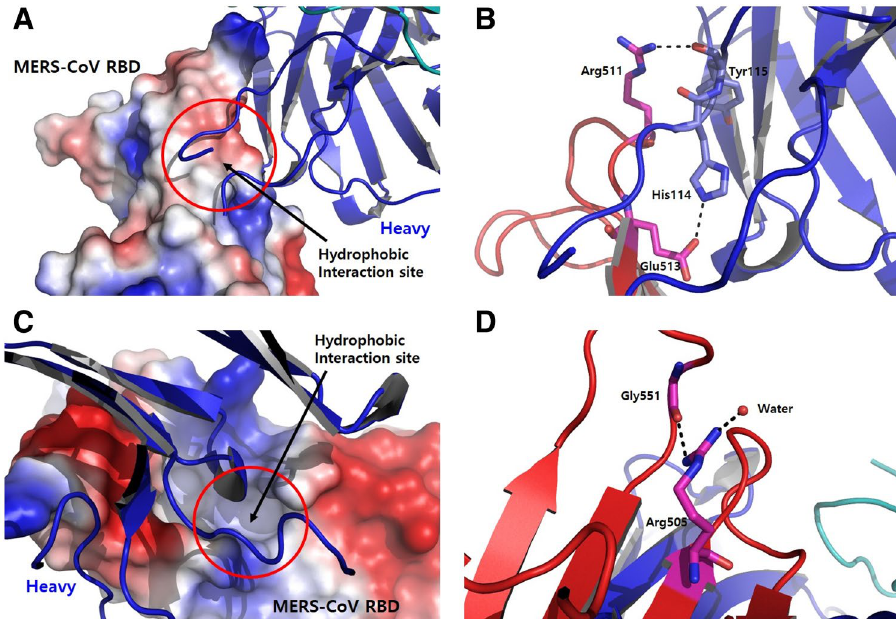
Figure 4. The hydrophobic interaction sites of MERS-CoV RBD complexed with KNIH90-F1 Fab. ( A ) The hydrophobic residues in the heavy chain of KNIH90-F1 Fab make contact with the hydrophobic region in the receptor-binding subdomain of RBD. ( B ) The hydrophobic interaction in ( A ) is reinforced by the interactions between Arg511 in RBD and Tyr115 in the heavy chain and between Glu513 in RBD and His114 in the heavy chain. ( C ) An additional hydrophobic interaction site between the receptor-binding subdomain of RBD and KNIH90-F1 Fab. ( D ) A key interaction between the Arg505 side chain, Gly551, and a water molecule induces the hydrophobic groove in ( C